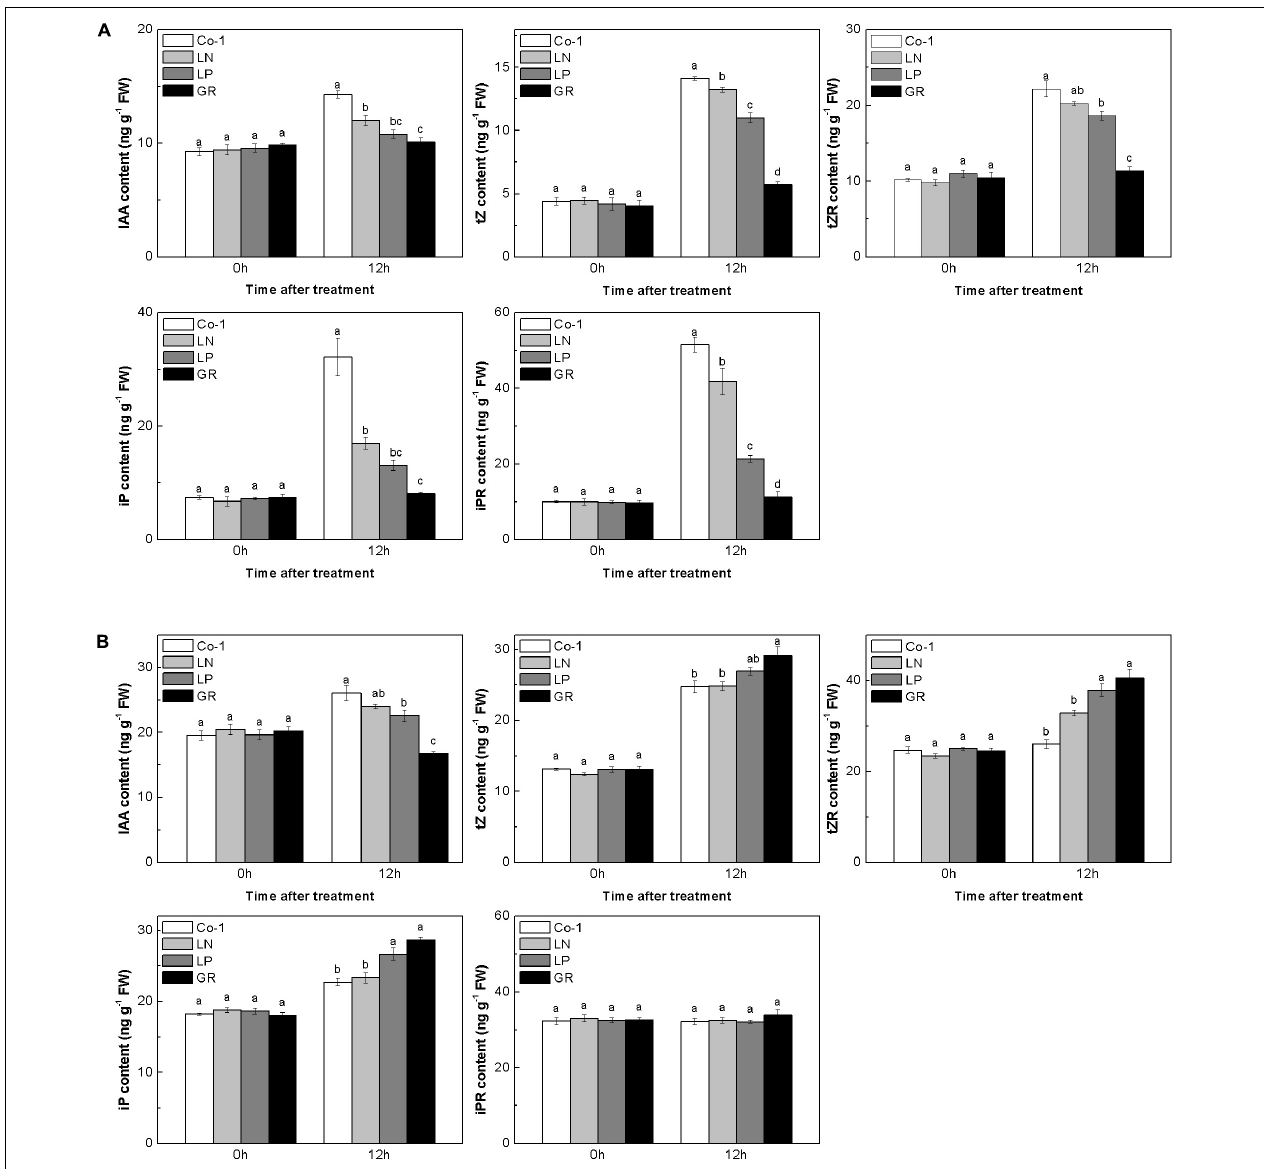
FIGURE 2 | Effect of N, phosphorous, and GR24 on the amounts of CK and indole-3-acetic (IAA) in rice tiller buds (A) and nodes (B) . At 0 and 12 h after treatment, the amounts of CK and IAA in rice tiller buds located at the fifth leaf axils and nodes were measured (tZ, tZR, iP, iPR). FW, fresh weight. Values in each column at the same amount of hormone followed by different letters were significantly different at p = 0.05 ( n =